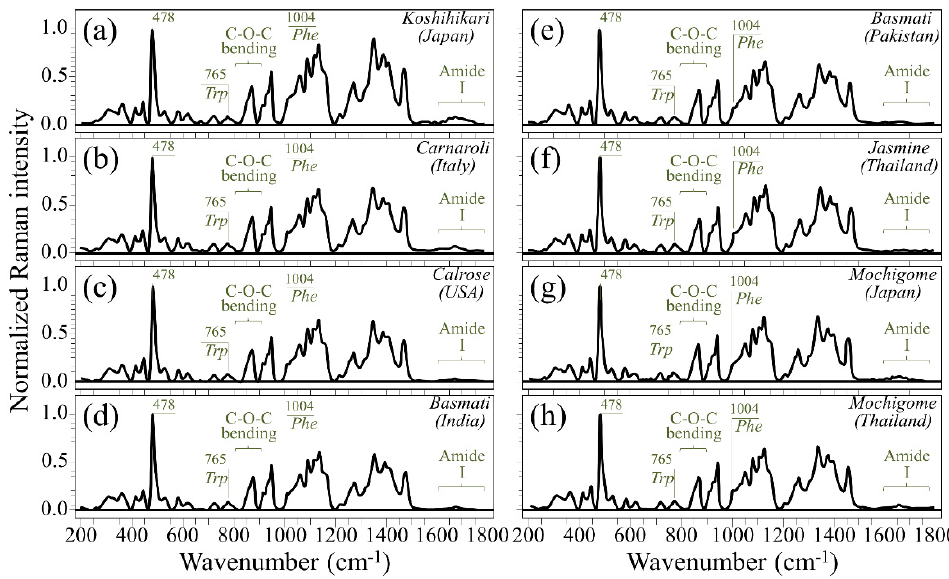
Figure 2. Low-resolution Raman spectra collected on as-received kernels of eight different rice cultivars (cf. labels in inset) in the spectral region 200–1800 cm − 1 ; the spectra are averaged over 30 spectra per each type of cultivar and normalized to the glucose ring stretching band at ~478 cm − 1 (cf. label in inset). The abbreviations Phe and Trp refer to phenylalanine and tryptophan, respectively, while the wavenumbers in inset are given in cm − 1 units. Insets: ( a ) Koshihikari (Japan), ( b ) Carnaroli (Italy), ( c ) Calrose (USA), ( d ) Basmati (India), ( e ) Basmati (Pakistan), ( f ) Jasmine (Thailand), ( g ) Mochigome (Japan) and ( h ) Mochigome (Thailand).